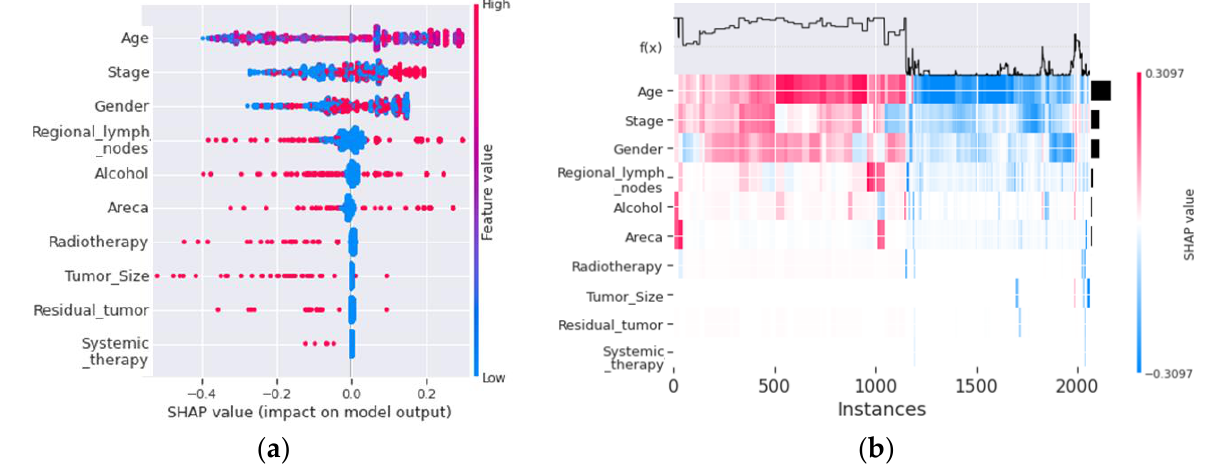
Figure 5. SHAP value plots: ( a ) bee swarm plot and ( b ) heat map.